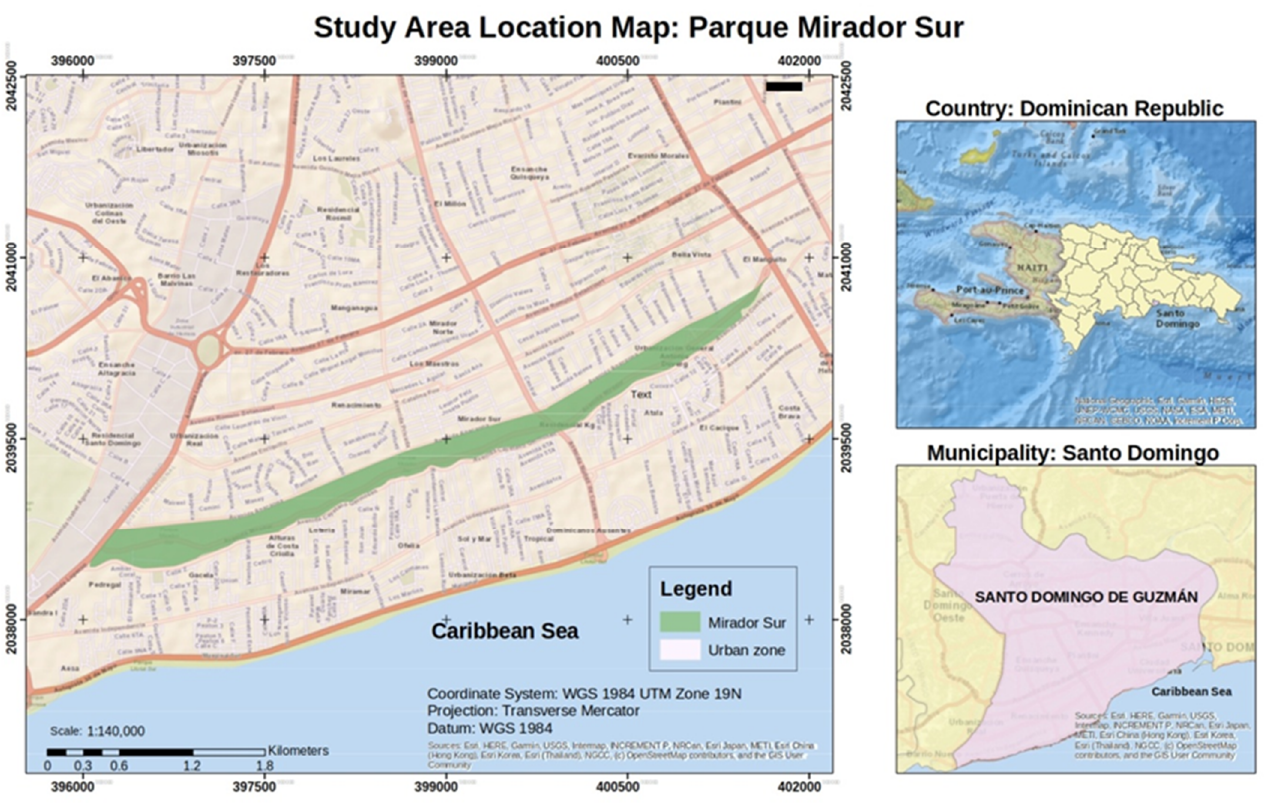
Figure 1. Mirador Sur Park, Santo Domingo, Dominican Republic.